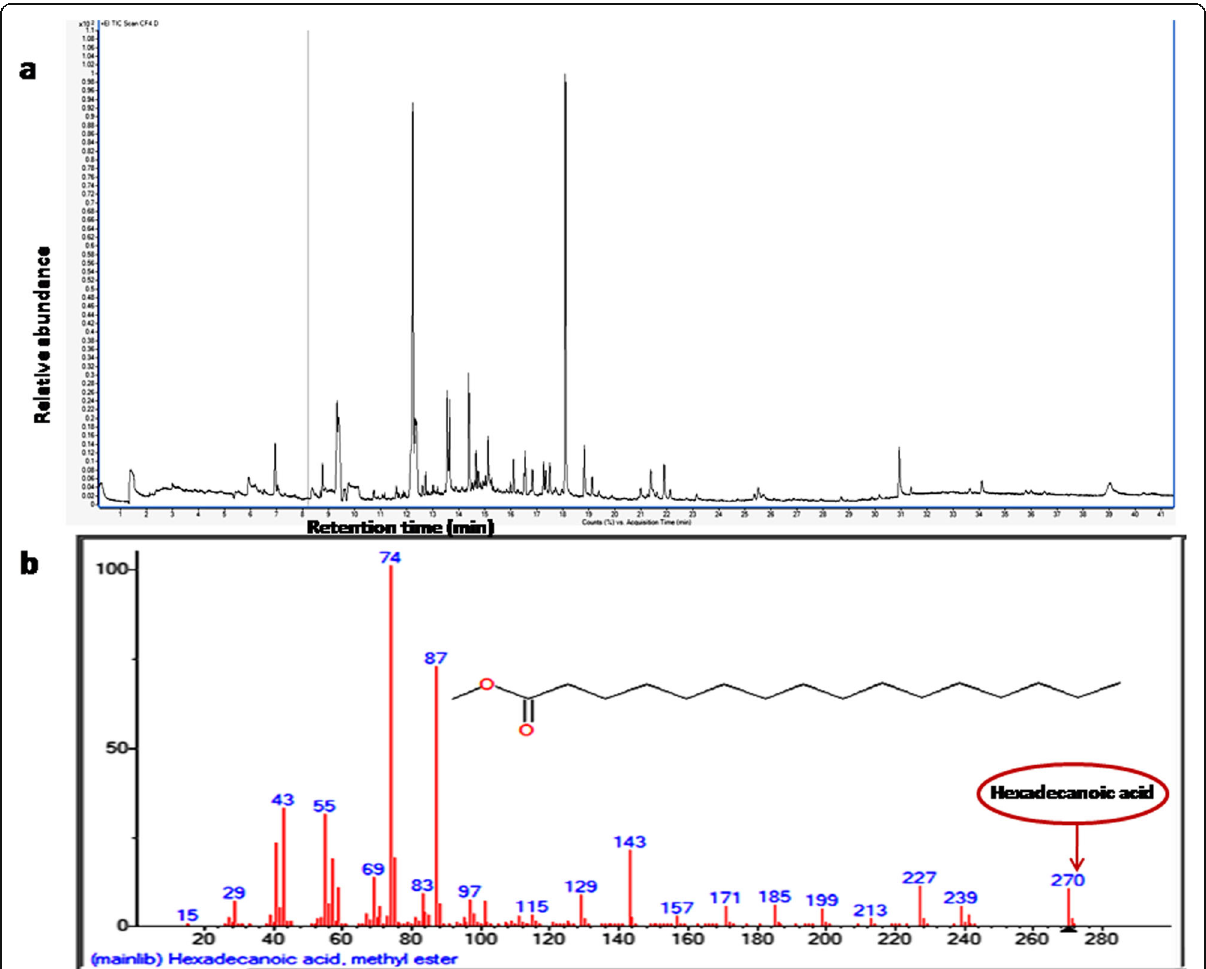
Fig. 3 GC-MS analysis of fraction CF4. a Gas chromatogram of bioactive fraction CF4. b Mass spectra of CF4 along with structure of hexadecanoic